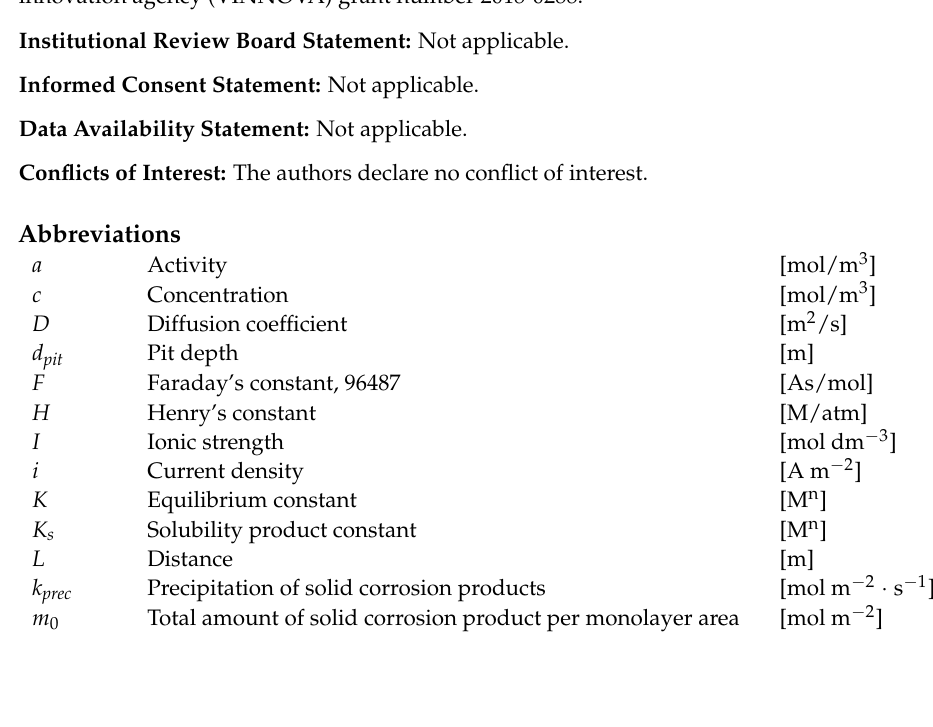
Figure S3: 2D diagrams of corrosion attacks on mapped regions of calibration cell surfaces after 5 h exposure with 86 µ g NaCl/cm 2 load at 21 ◦ C in (a) 85%, (b) 91%, and (c) 97% RH. Mapped regions represent the black frames in Figure 7; Figure S4: Localized corrosion attack on the aluminum surface close to the stainless steel. Sample with 86 µ g/cm 2 NaCl exposed at 97% RH; Figure S5: FTIR spectrum collected at a corrosion pit (center) and reference spectra of Al(OH) 2 Cl and Al 2 (OH) 5 Cl · 2H 2 O. Sample with 86 µ g/cm 2 NaCl exposed at 97% RH; Figure S6: FTIR spectrum collected at a corrosion pit and reference spectra of amorphous aluminum hydroxide containing carbonate (Al(OH) 3 − 2x (CO 3 ) x . Sample with 86 µ g/cm 2 NaCl exposed at 97% RH; Figure S7: FTIR spectrum collected on two locations outside a corrosion pit and reference spectra of Dawsonite, NaAlCO 3 (OH) 2 . Sample with 86 µ g/cm 2 NaCl exposed at 97% RH; Figure S8. FTIR spectrum collected on the stainless-steel surface. Sample with 86 µ g/cm 2 NaCl exposed at 97%